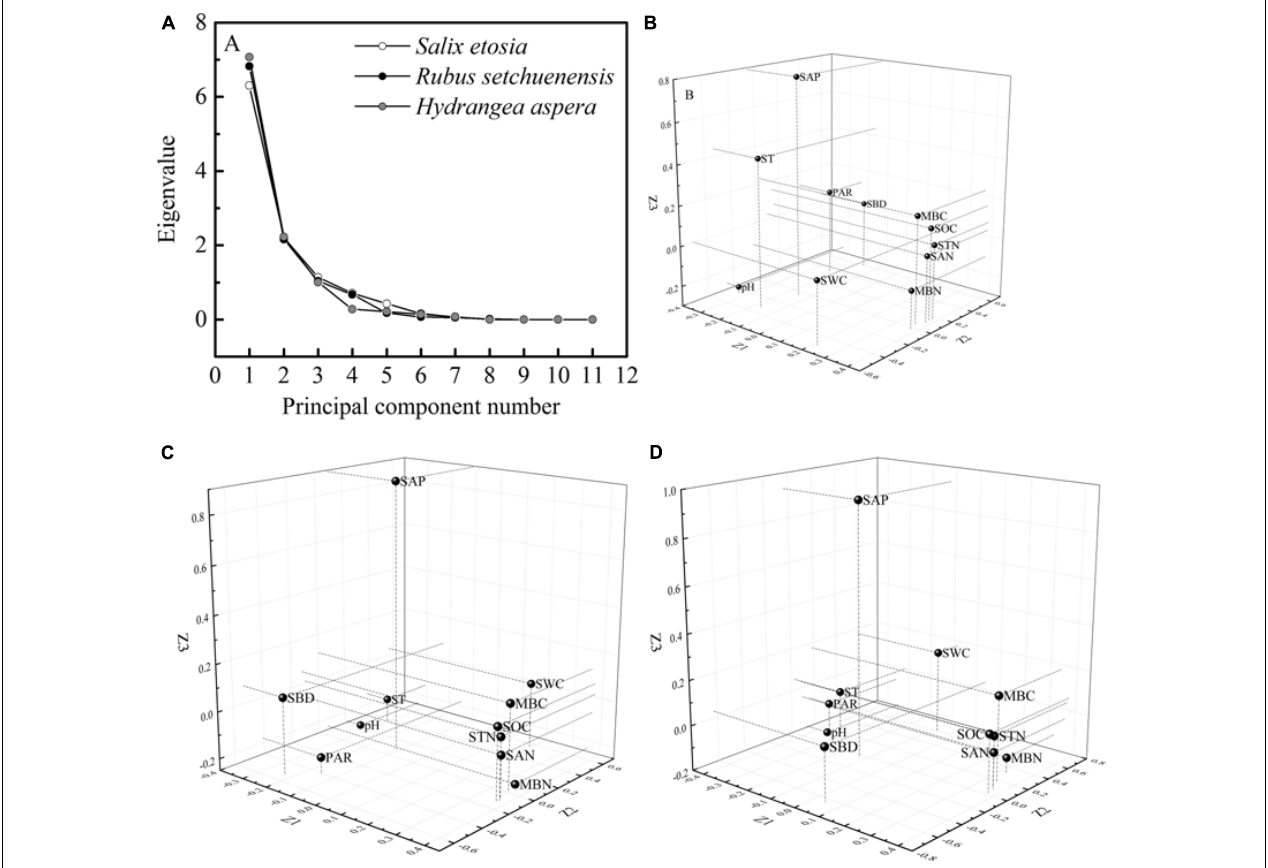
FIGURE 4 | Principal component analysis (PCA) of abiotic factors and biotic factors on leaf trait and biomass allocation of three shrubs. (A) Scree plot of three species’ principal components; (B–D) load factor graph and PCA of Salix etosia , Rubus setchuenensis , and Hydrangea aspera ,